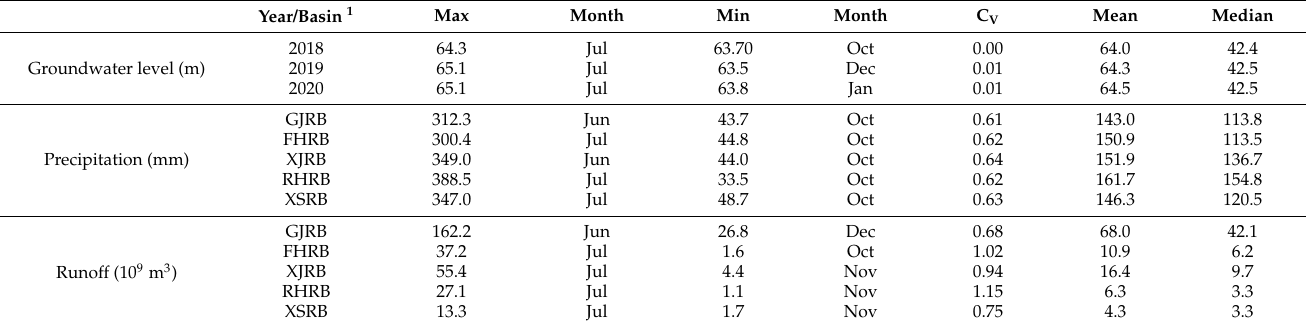
Table 1. Statistical characteristics of groundwater level, precipitation, and runoff in the study